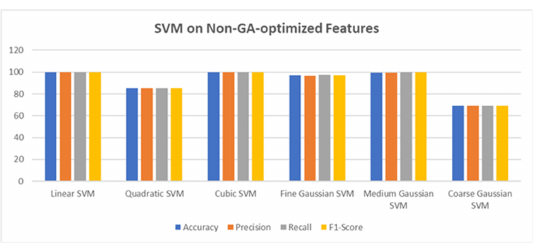
Figure 9. Graphical comparison of various SVM kernels on non-GA-optimized features